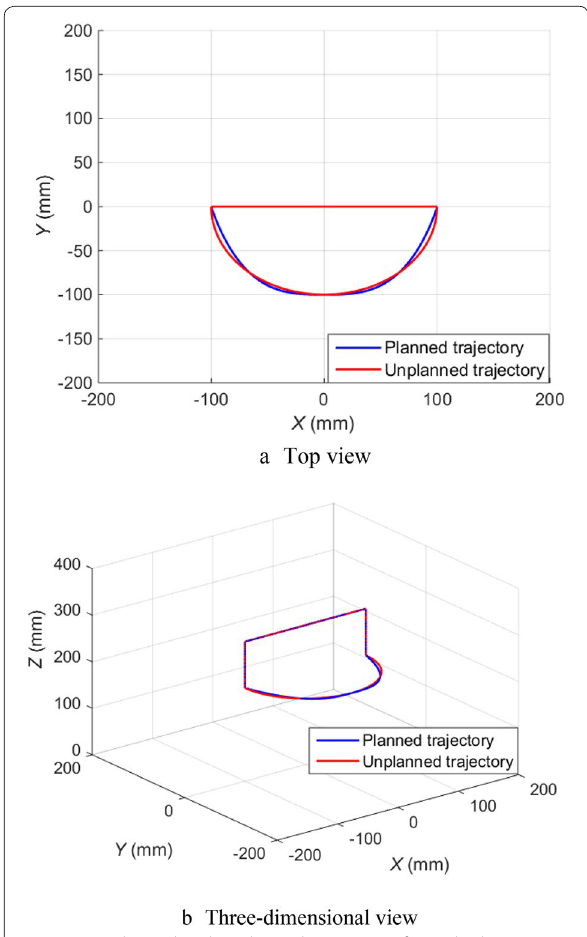
Figure 11 Planned and unplanned trajectories for cycloid trajectory